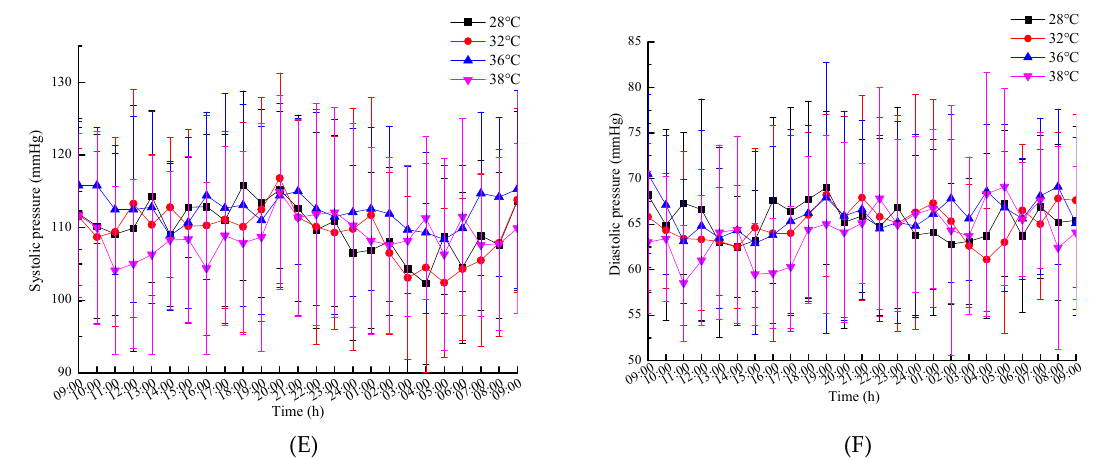
Figure 4. The mean values and standard deviations of the results of the physiological parameters: (A) Rectal temperature; (B) eardrum temperature; (C) forehead temperature; (D) heart rate; (E) systolic pressure; (F) diastolic pressure.